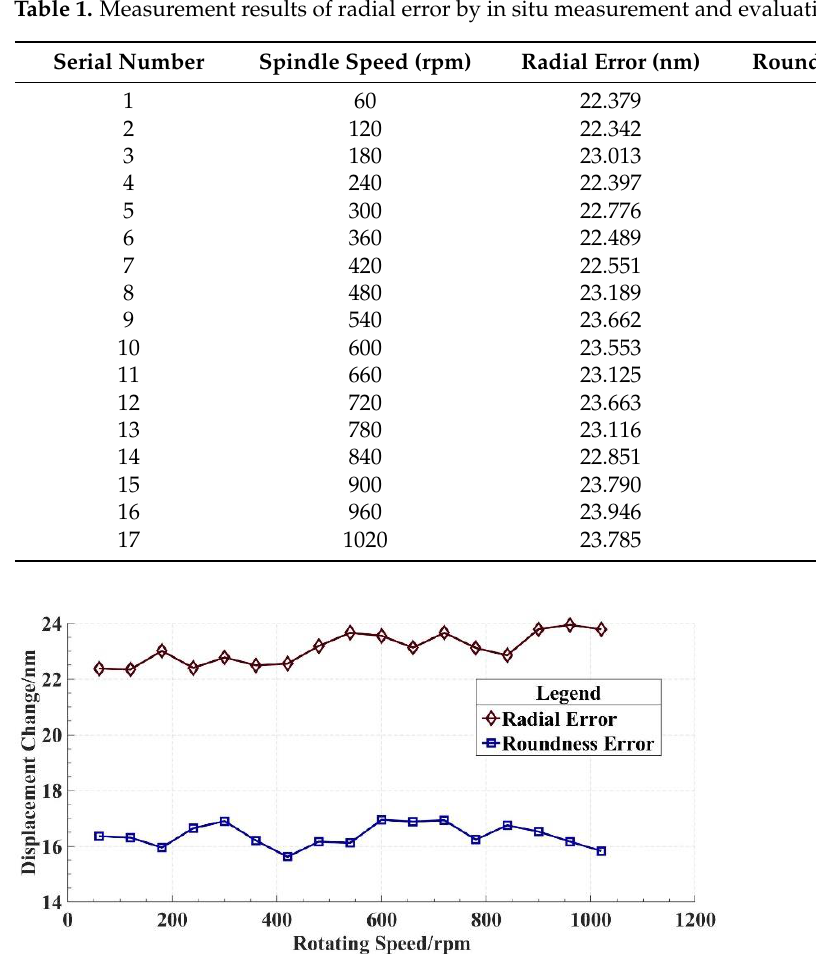
Table 1. Measurement results of radial error by in situ measurement and evaluation system.